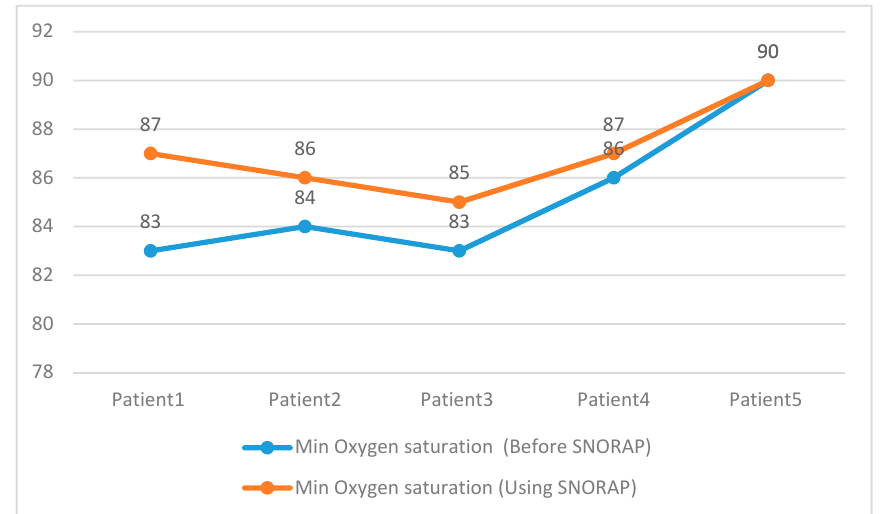
Figure 12. Min O 2 Saturation.